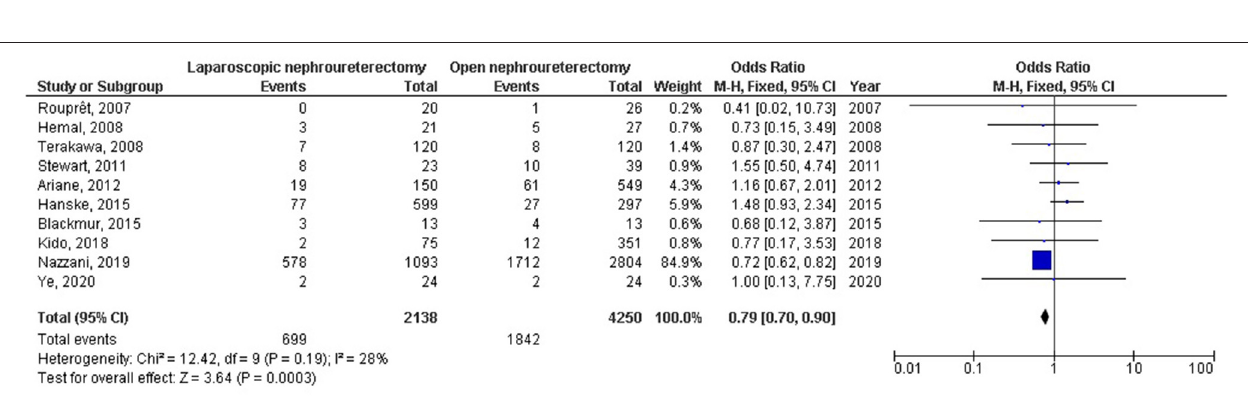
FIGURE 8 | Forest plot of the effect of open nephroureterectomy compared with laparoscopic nephroureterectomy on 2–5 years cancer-specific survival in subjects with upper urinary tract urothelial carcinoma.